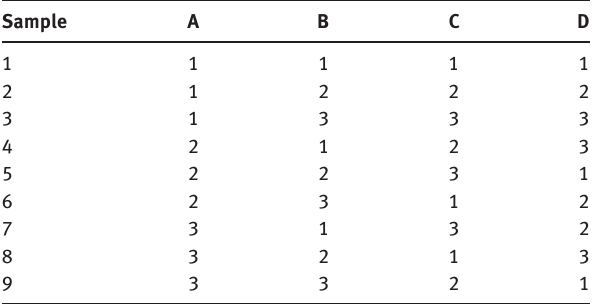
Table 2: Design of orthogonal test. Sample